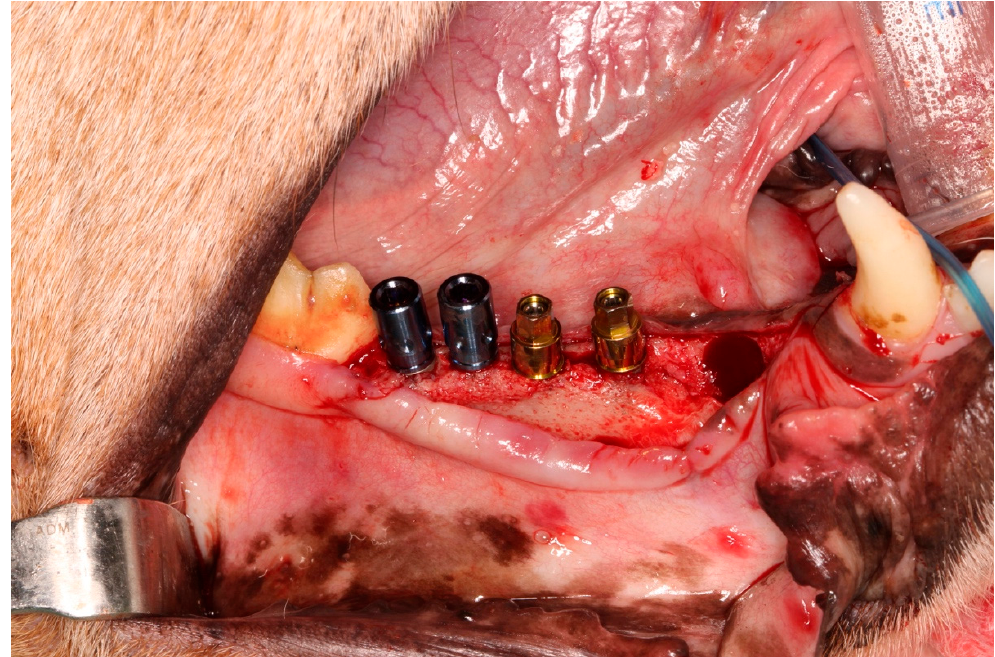
Figure 2. Four implants of two different types, placed in each dog´s